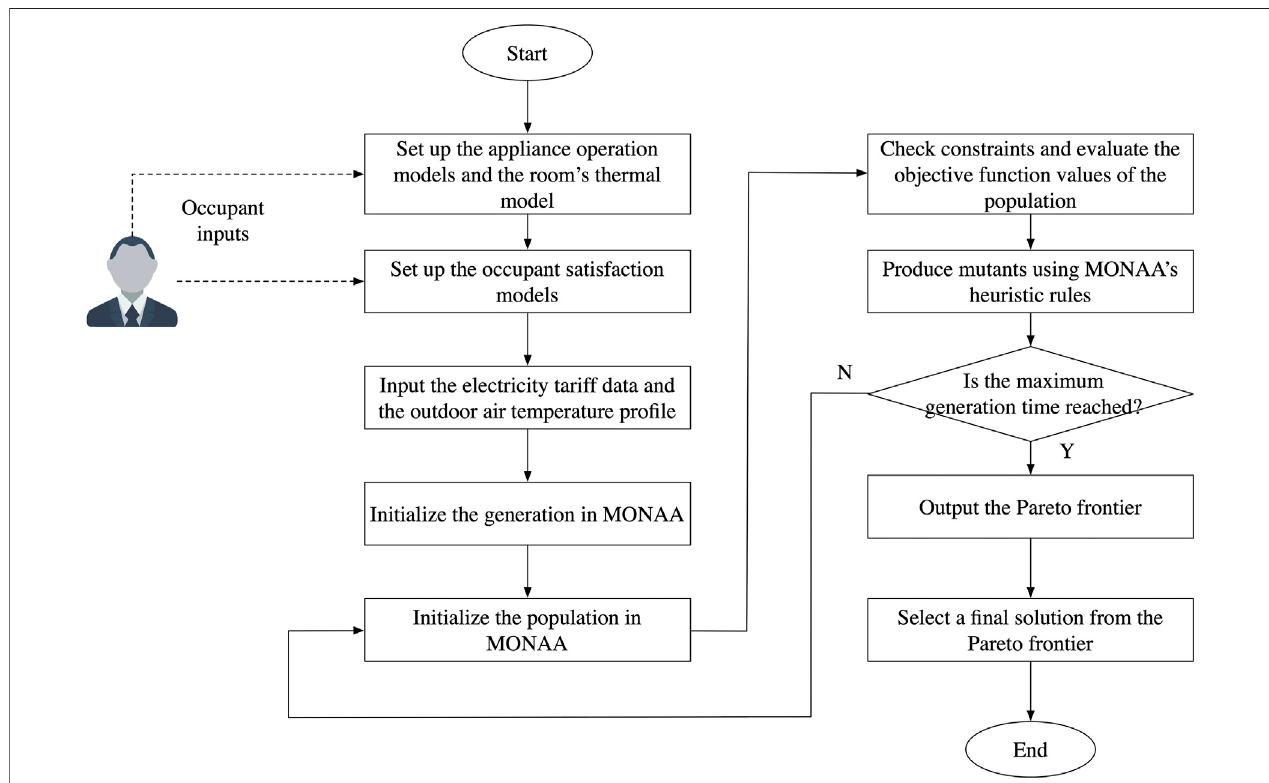
FIGURE 7 | Solving work fl ow for the proposed